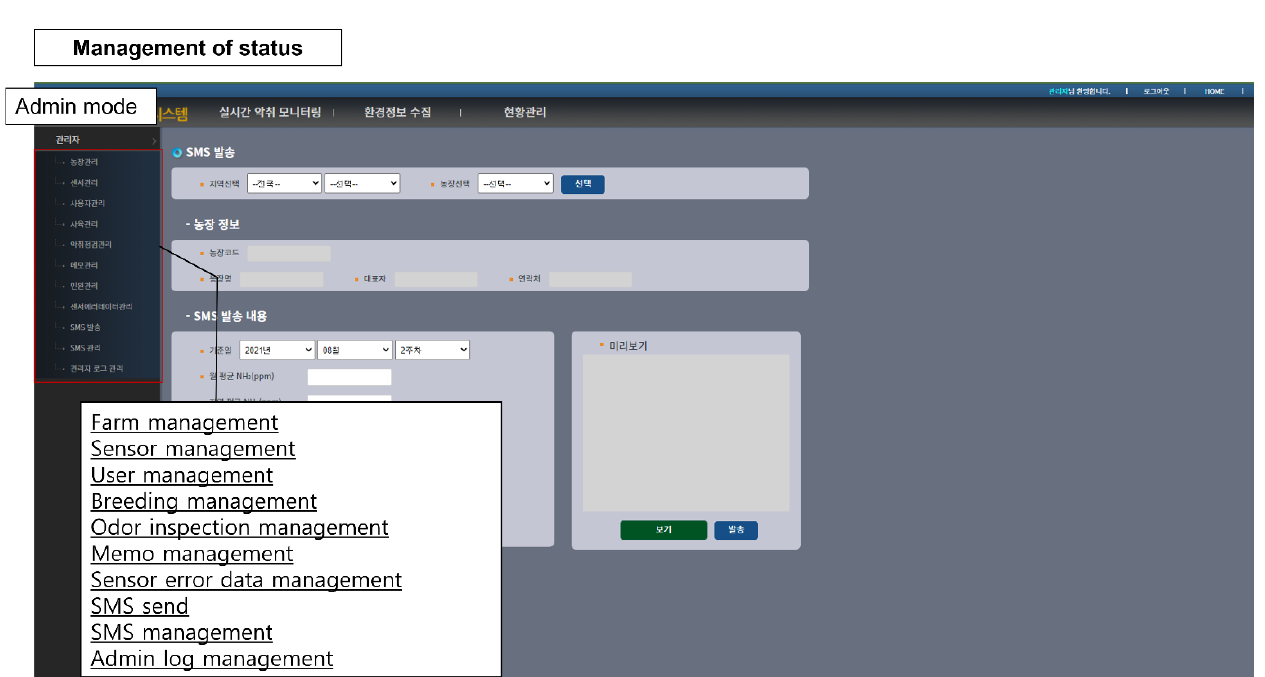
Figure 5. The web page of management of status in the livestock odor control system (i.e., farm, sensor, user, breeding, odor inspection, memo, sensor error data, SMS send, and admin login